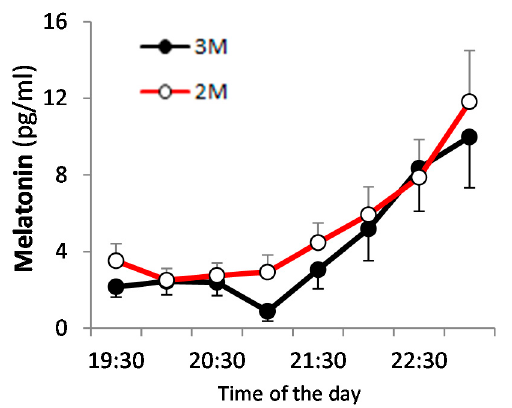
Figure 4. Dim light melatonin onset (DLMO) in saliva. Saliva melatonin profiles are presented as the mean value ± SEM for the 2 dietary conditions. The closed circles indicate the 3M condition ( ) and the open circles indicate the 2M condition ( ). 3.3. Heart Rate Variability Figure 2B–D shows double plots of the mean value for heart rate, LF/HF, and log HF in the two dietary conditions. Heart rate was higher during the day than at night in both dietary conditions, particularly when subjects consumed a meal. LF/HF was higher during the day than at night in both dietary conditions, while log HF increased during the night and decreased during the day. Figure 3B–D shows the circular correlation coefficients of heart rate, LF/HF, and log HF in the two dietary conditions, and no statistical significance of a non-zero mean.